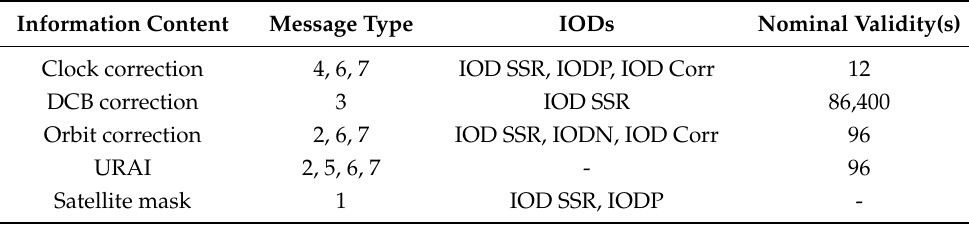
Table 1. Information of PPP-B2b